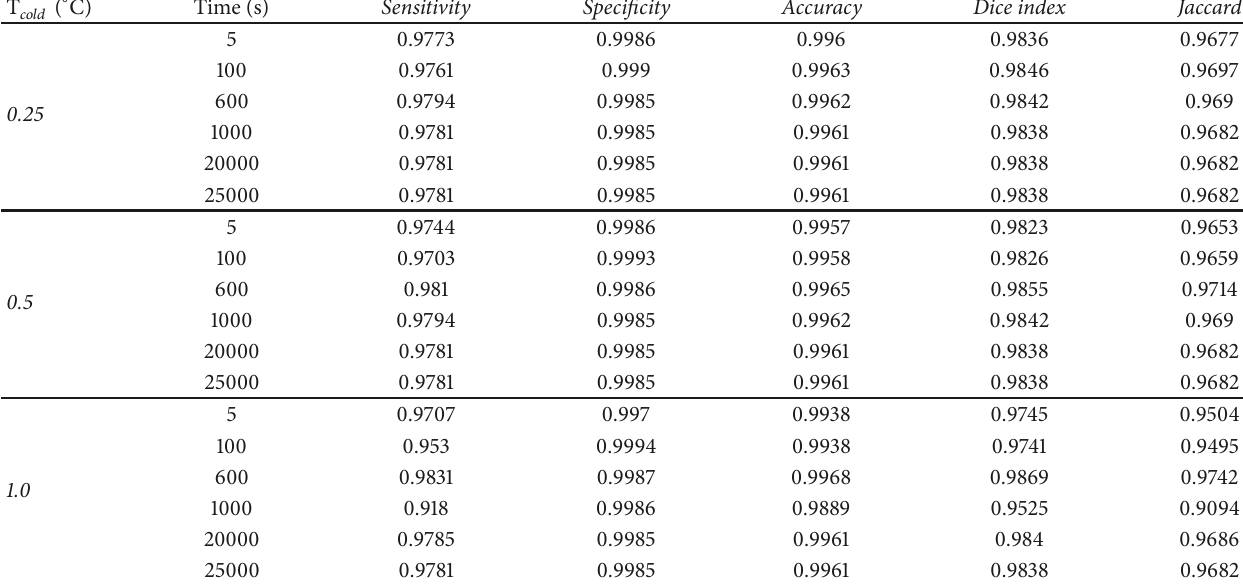
Table 4: The calculated segmentation evaluation metrics for transient thermal analysis in brain tumor contours